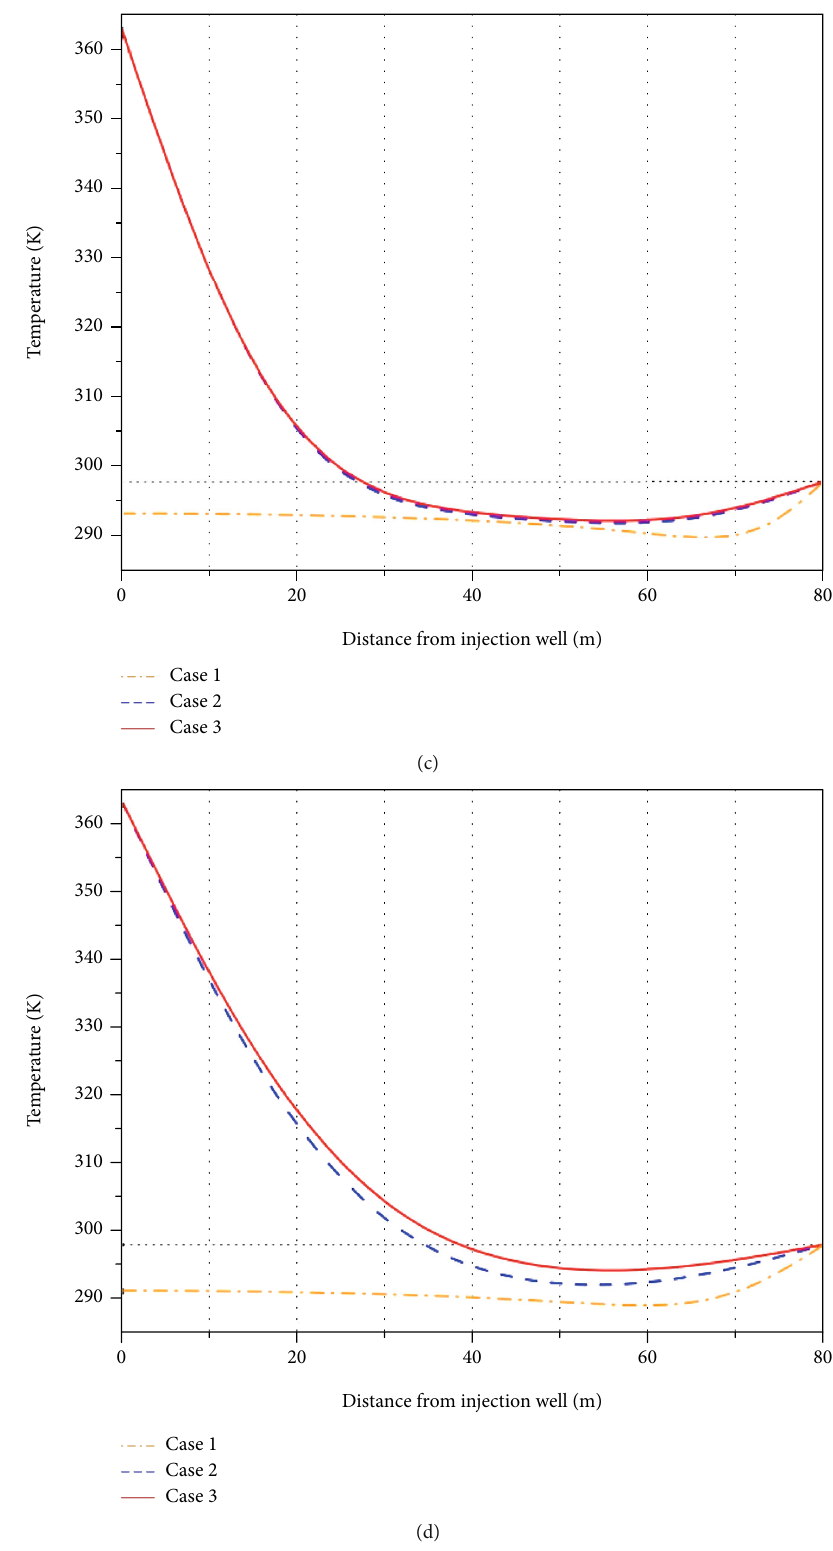
Figure 11: The spatial distribution of temperature for three di ff erent cases at monitoring line after (a) one-year, (b) four-year, (c) ten-year, and (d) twenty-year